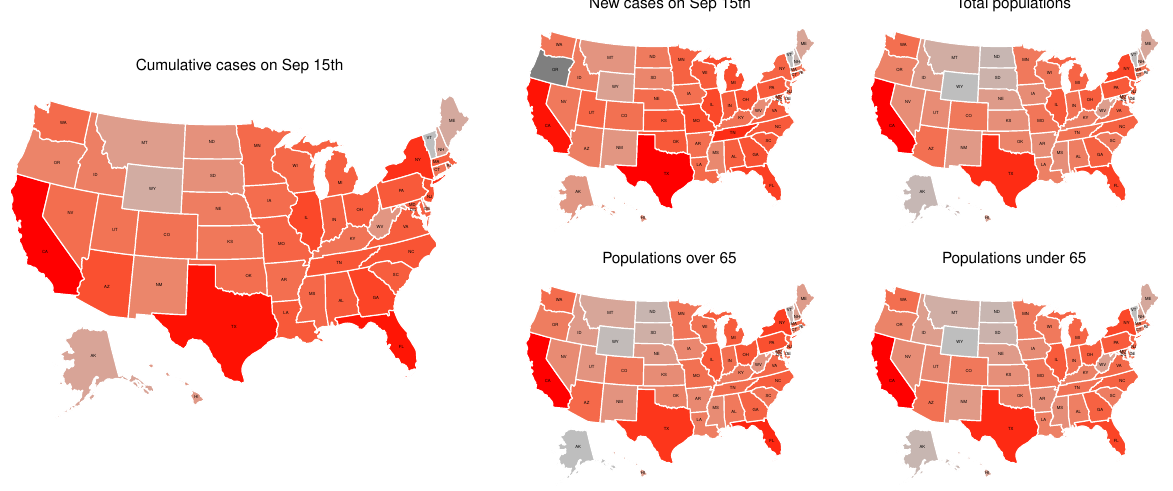
Figure 2. State-level population related information. We took the logarithm of the original data for better visualization.